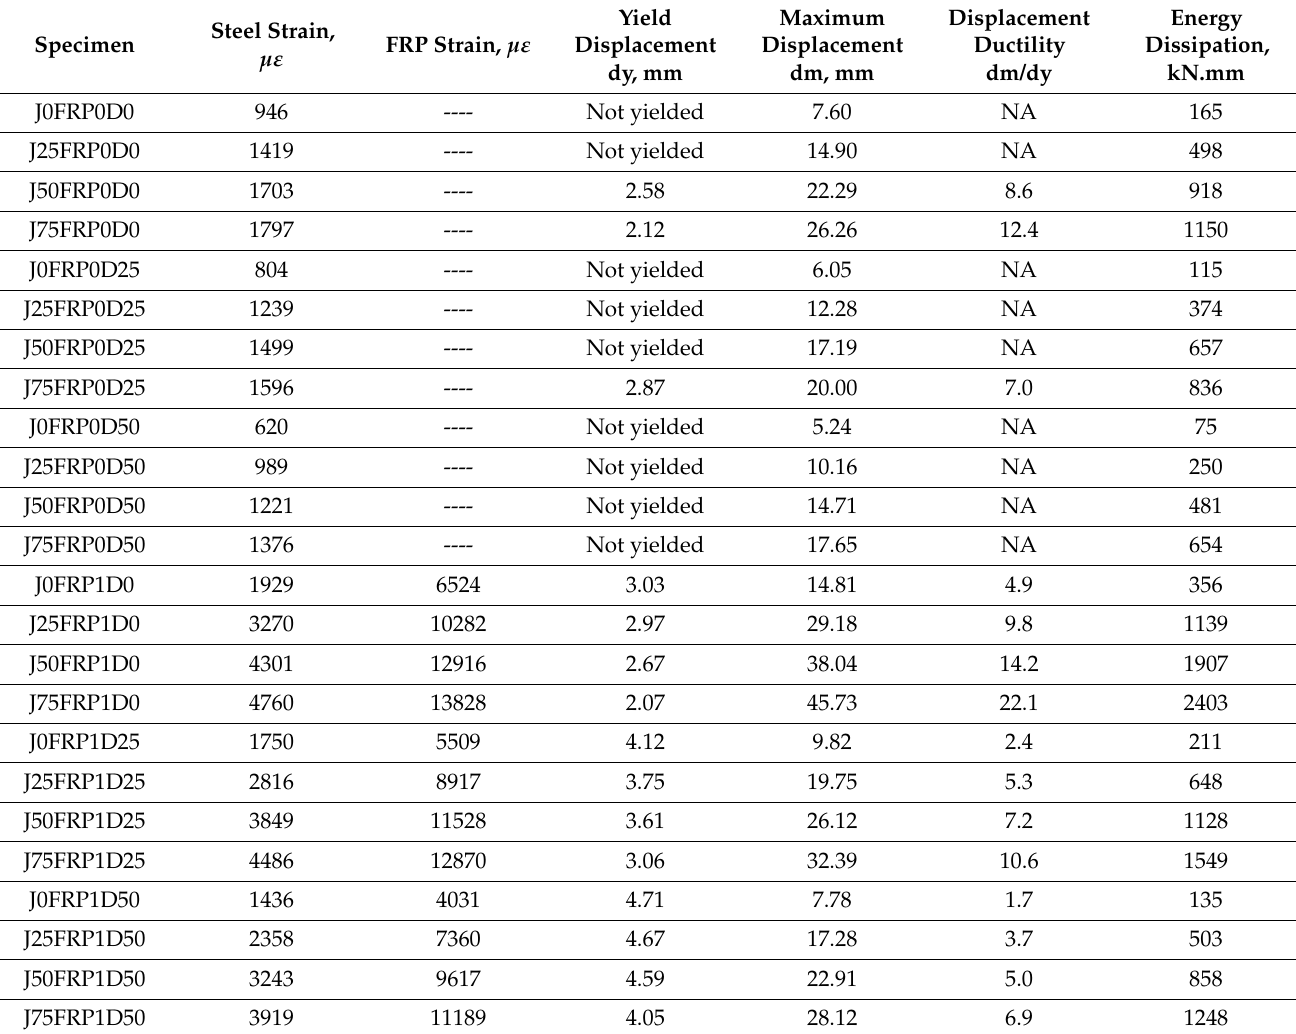
Table 3. Various structural characteristics of the simulated